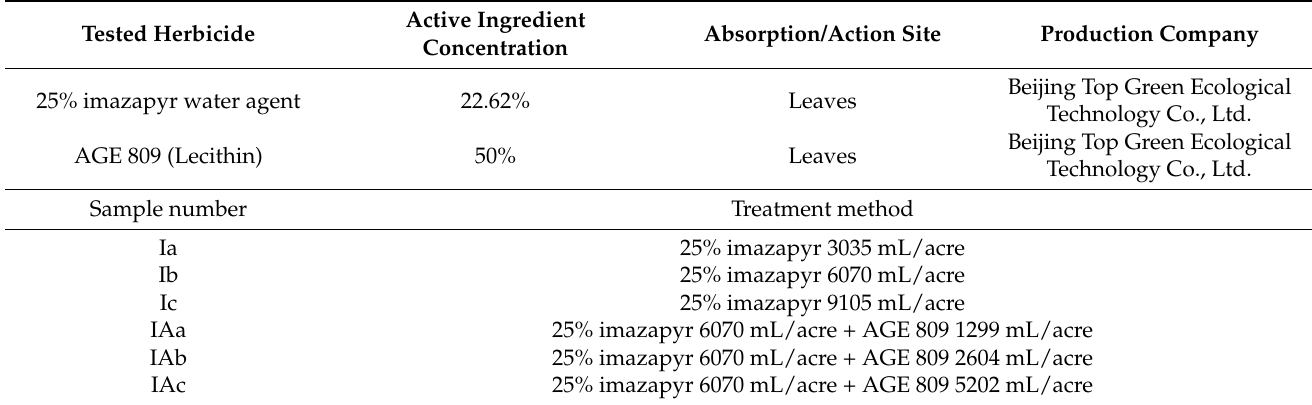
Table 1. Agents and treatment methods.